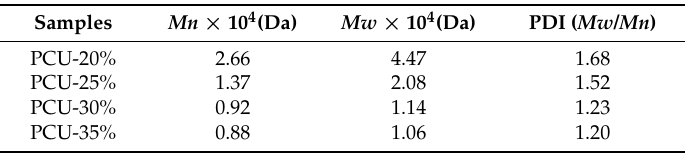
Table 1. Molecular weights and molecular weight distributions of the synthesized polycarbonate urethanes (PCUs) used in this work. Here, polyurethanes are denoted as PCU-x%, where x is the hard segment weight fraction.